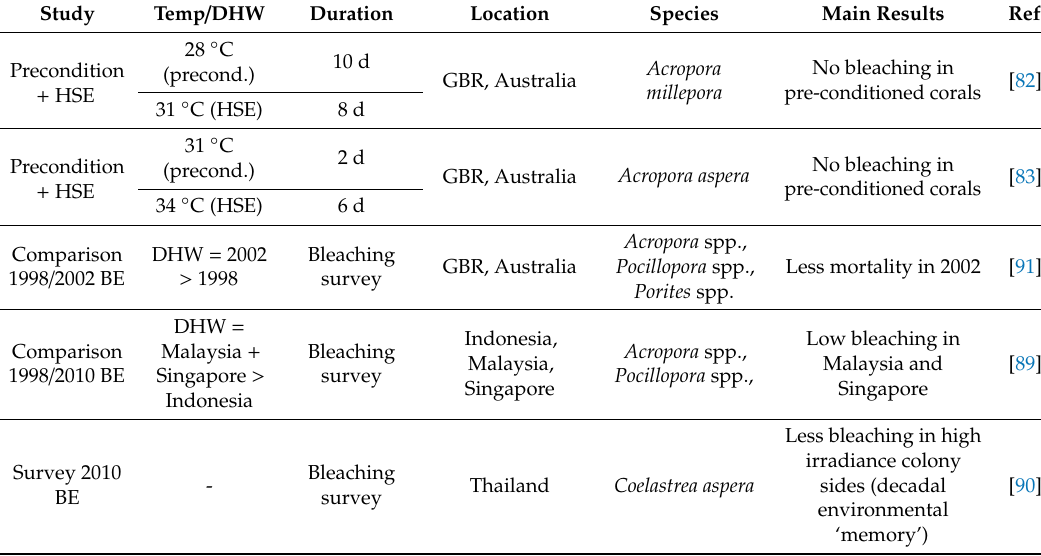
Table 1. Studies performed to test acclimatisation to thermal stress and high temperature variability at di ff erent locations around the